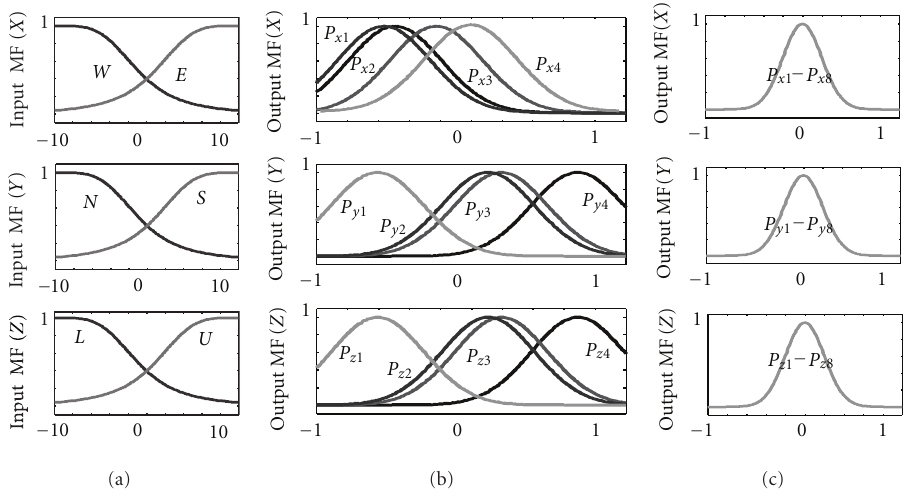
Figure 5: Input and output membership